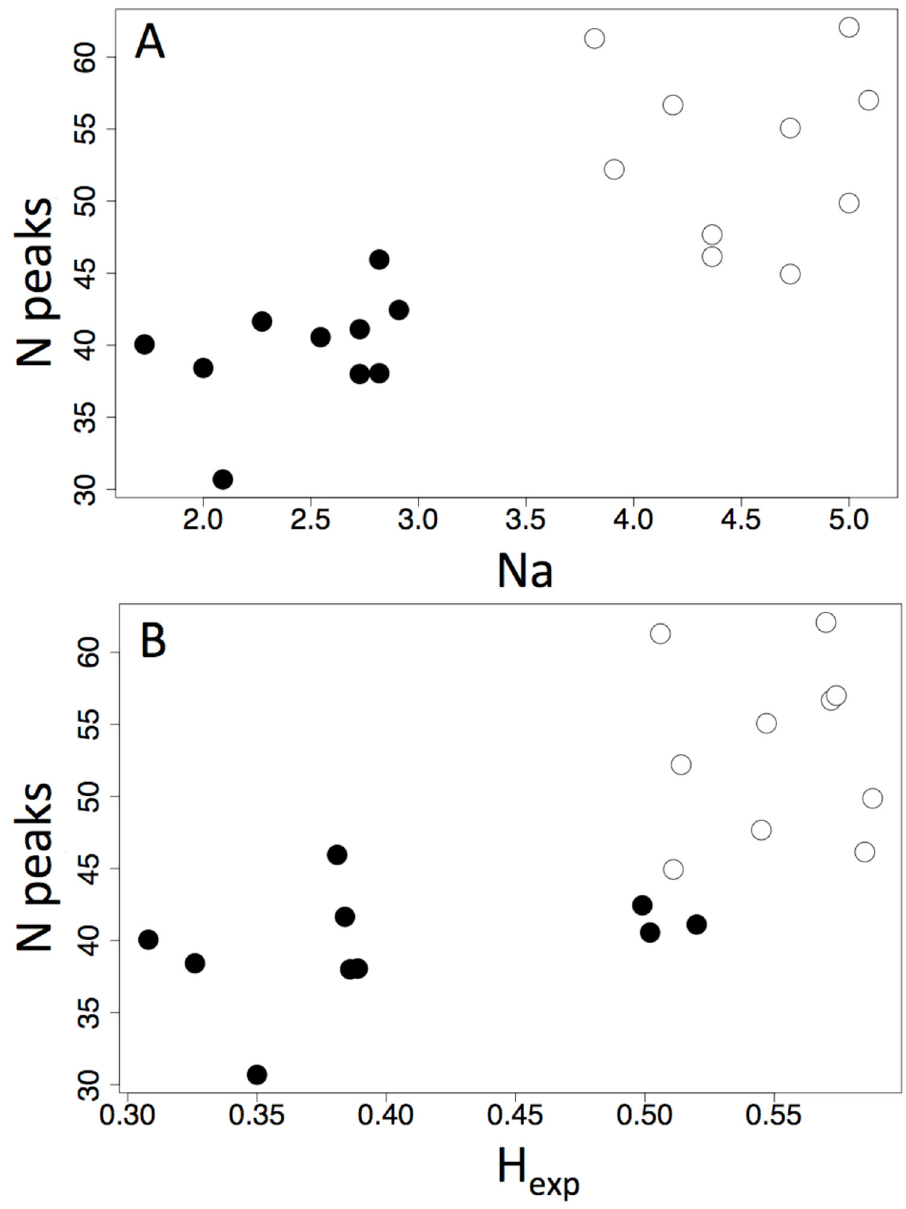
Fig 2. Measurements of genetic diversity plotted against chemical diversity. Average number of alleles (A) and average expected heterozygosity (B) of free-living and enslaved colonies of F . altipetens (x axes) relative to the average number of chemical peaks found per individual within each colony (y axes). Shaded points represent free-living colonies of F . altipetens and open points represent colonies with enslaved F . altipetens . Only individuals for which we acquired both chemical and genetic data from were included in this analysis (146 enslaved and 173 free-living F . altipetens workers; 10 colonies of enslaved, 10 colonies of free-